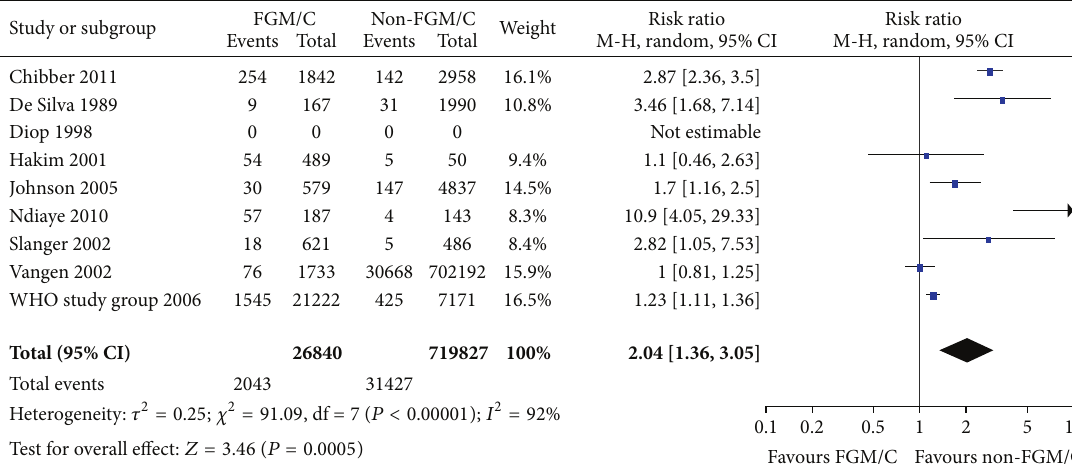
Figure 7: Forest plot, obstetric/post-partum hemorrhage. Note: Sensitivity analyses for outcome (definition) and study type were not statistically significant. Data were missing in Diop et al. [34], and we did not succeed in obtaining data from the authors; thus, results from this study are not estimable.